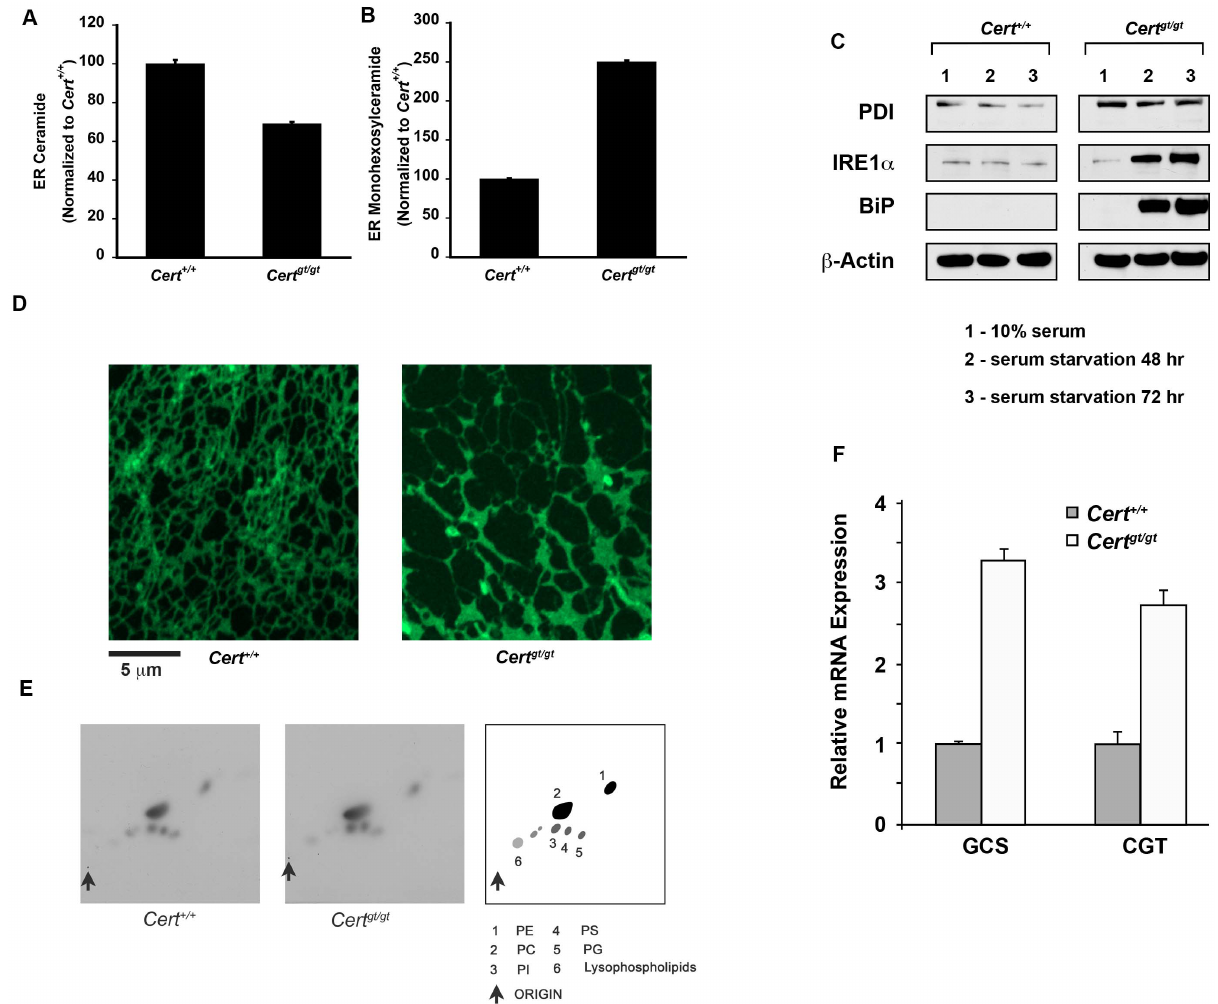
Figure 2. CERT deficiency leads to incipient ER stress in Cert gt/gt MEFs. (A) The total ER ceramide levels are slightly decreased while (B) hexosylceramide levels are increased in Cert gt/gt compared to the control Cert + / + MEFs. (C) Basal PDI levels are increased in the mutant MEFs. Upon serum starvation the levels of IRE1 a and BiP are increased in the mutant cells. (D) The ER was labeled with ER tracker green. The ER in the mutant show altered morphology and altered dynamics (see videos S1 and S2). (E). Metabolic labeling for phospholipids were performed using 32 P- orthophosphoric agent as a substrate. No visible difference in major phospholipids was observed between the wild type control and the mutant cells. (F) qPCR analysis of transcripts for GLUCS and GALCS shows increased transcript levels in P5 Cert gt/gt compared to the Cert + / + MEFs.